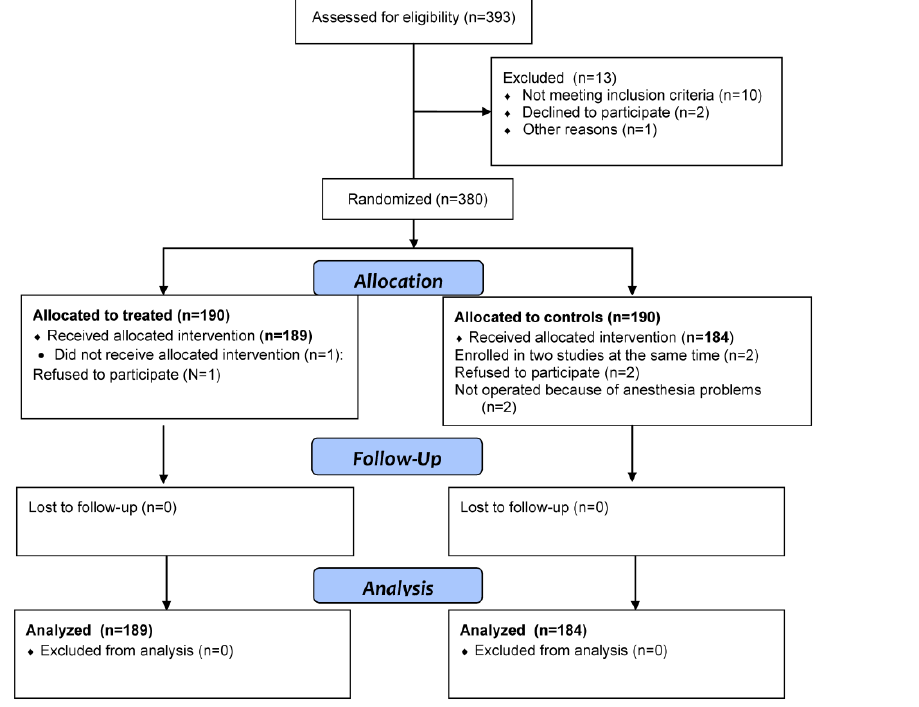
Figure 1. Consort flow diagram of patient